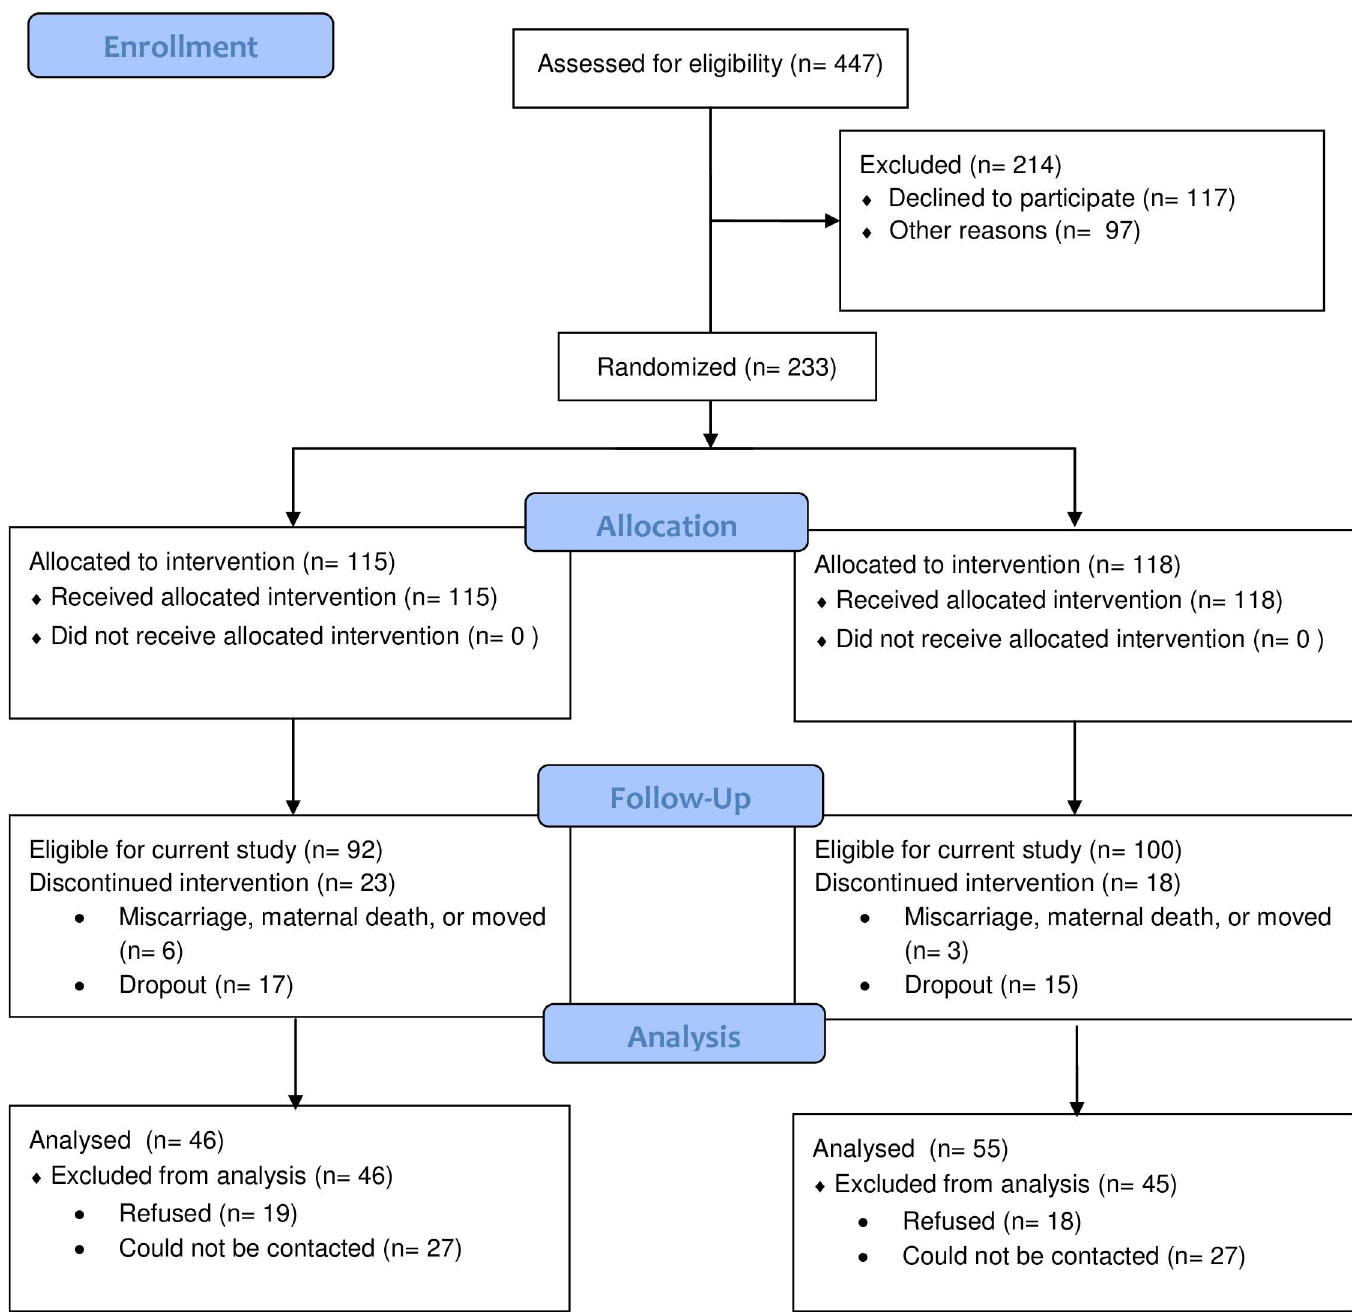
Fig 1. CONSORT Flow